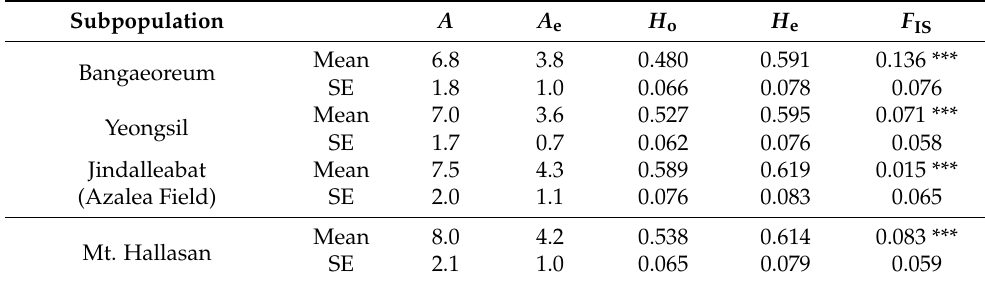
Table 3. Genetic diversity of Abies koreana subpopulations. Subpopulation A A e H o H e